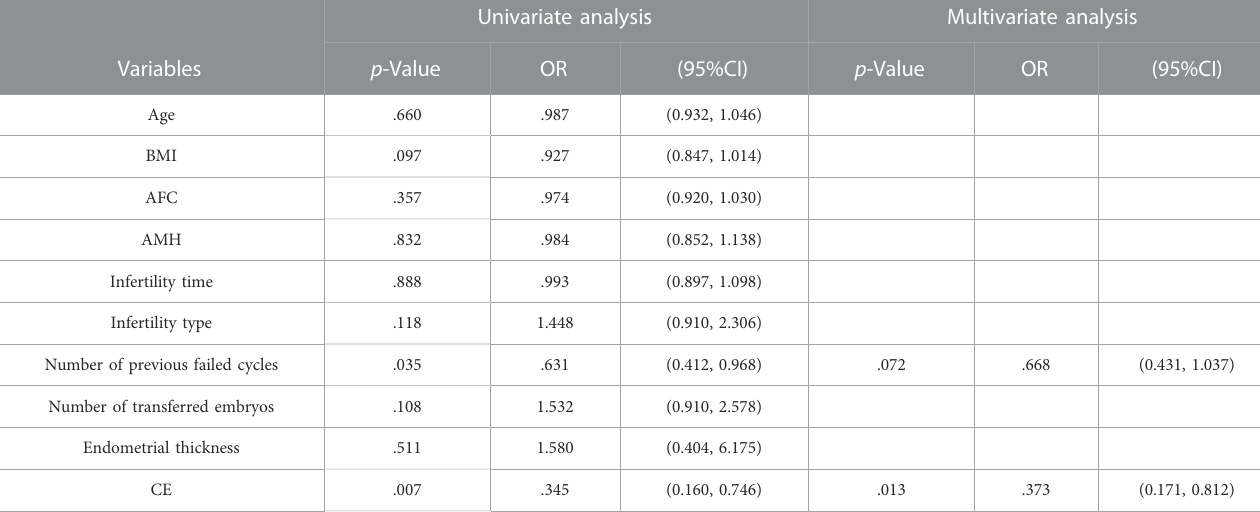
TABLE 3 Logistic regression analysis of factors affecting the clinical pregnancy